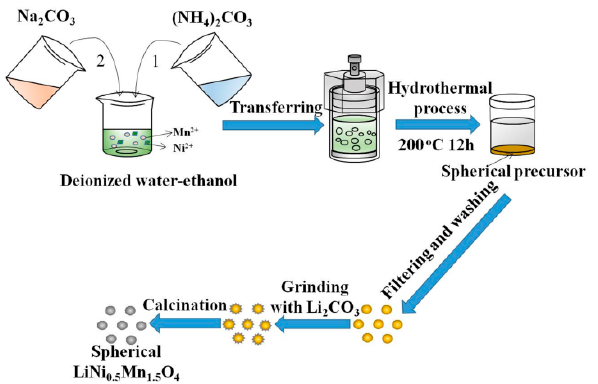
Figure 1. Diagrammatic illustration of the synthesis process for LiNi 0.5 Mn 1.5 O 4 (LNMO) cathode materials.